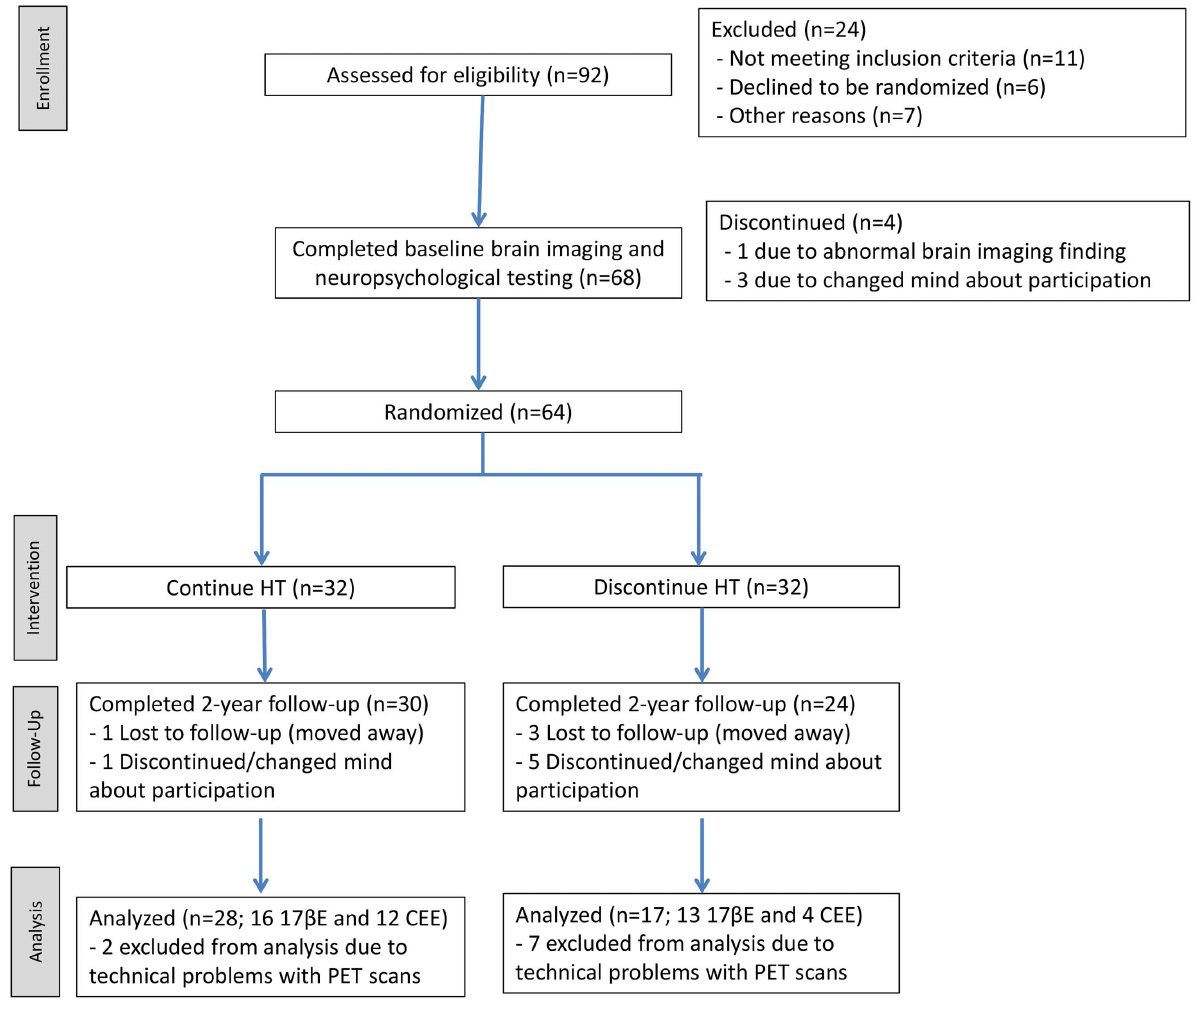
Figure 1. Study Subject Flow.